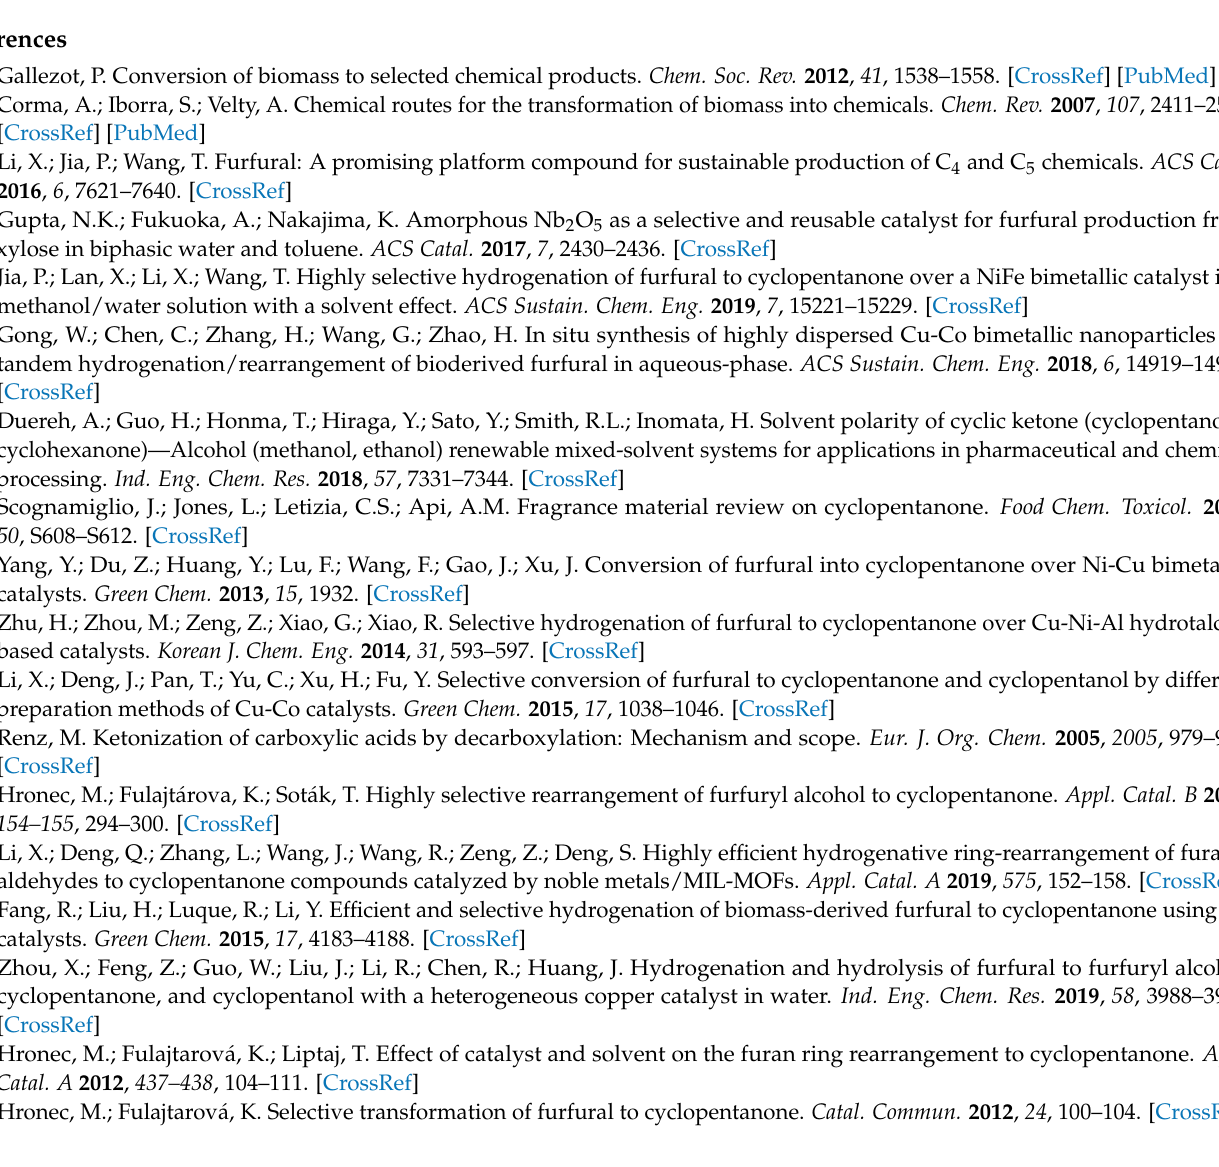
Figure S1: XRD patterns, Figure S2: SEM images, Figure S3: N 2 adsorption/desorption isotherms, Figure S4: XRD patterns, Figure S5: TEM image; Table S1: Textural properties of the catalyst